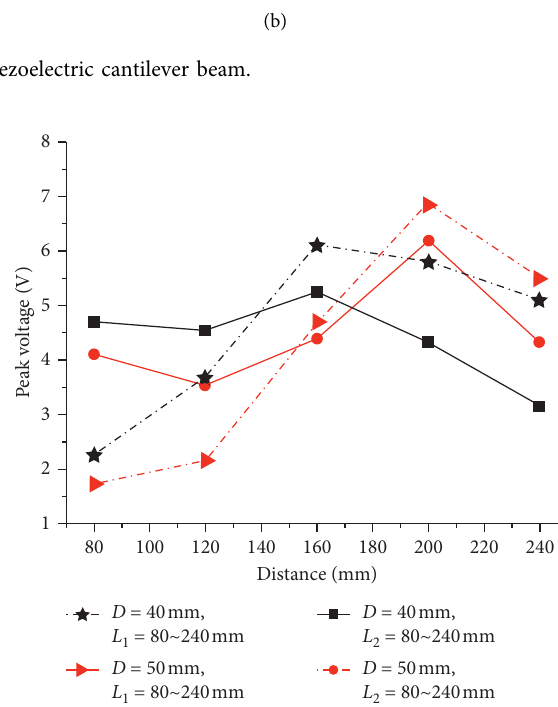
Figure 15: The peak open-circuit voltage relative to the fixed spots and diameters of bluff